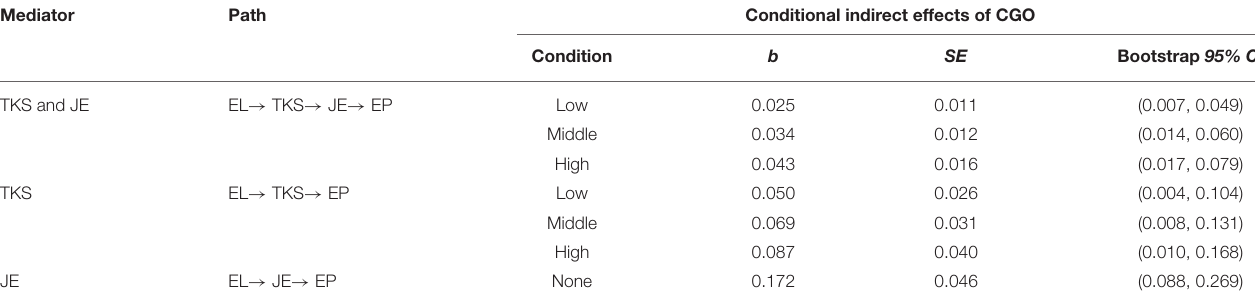
TABLE 5 | Conditional process